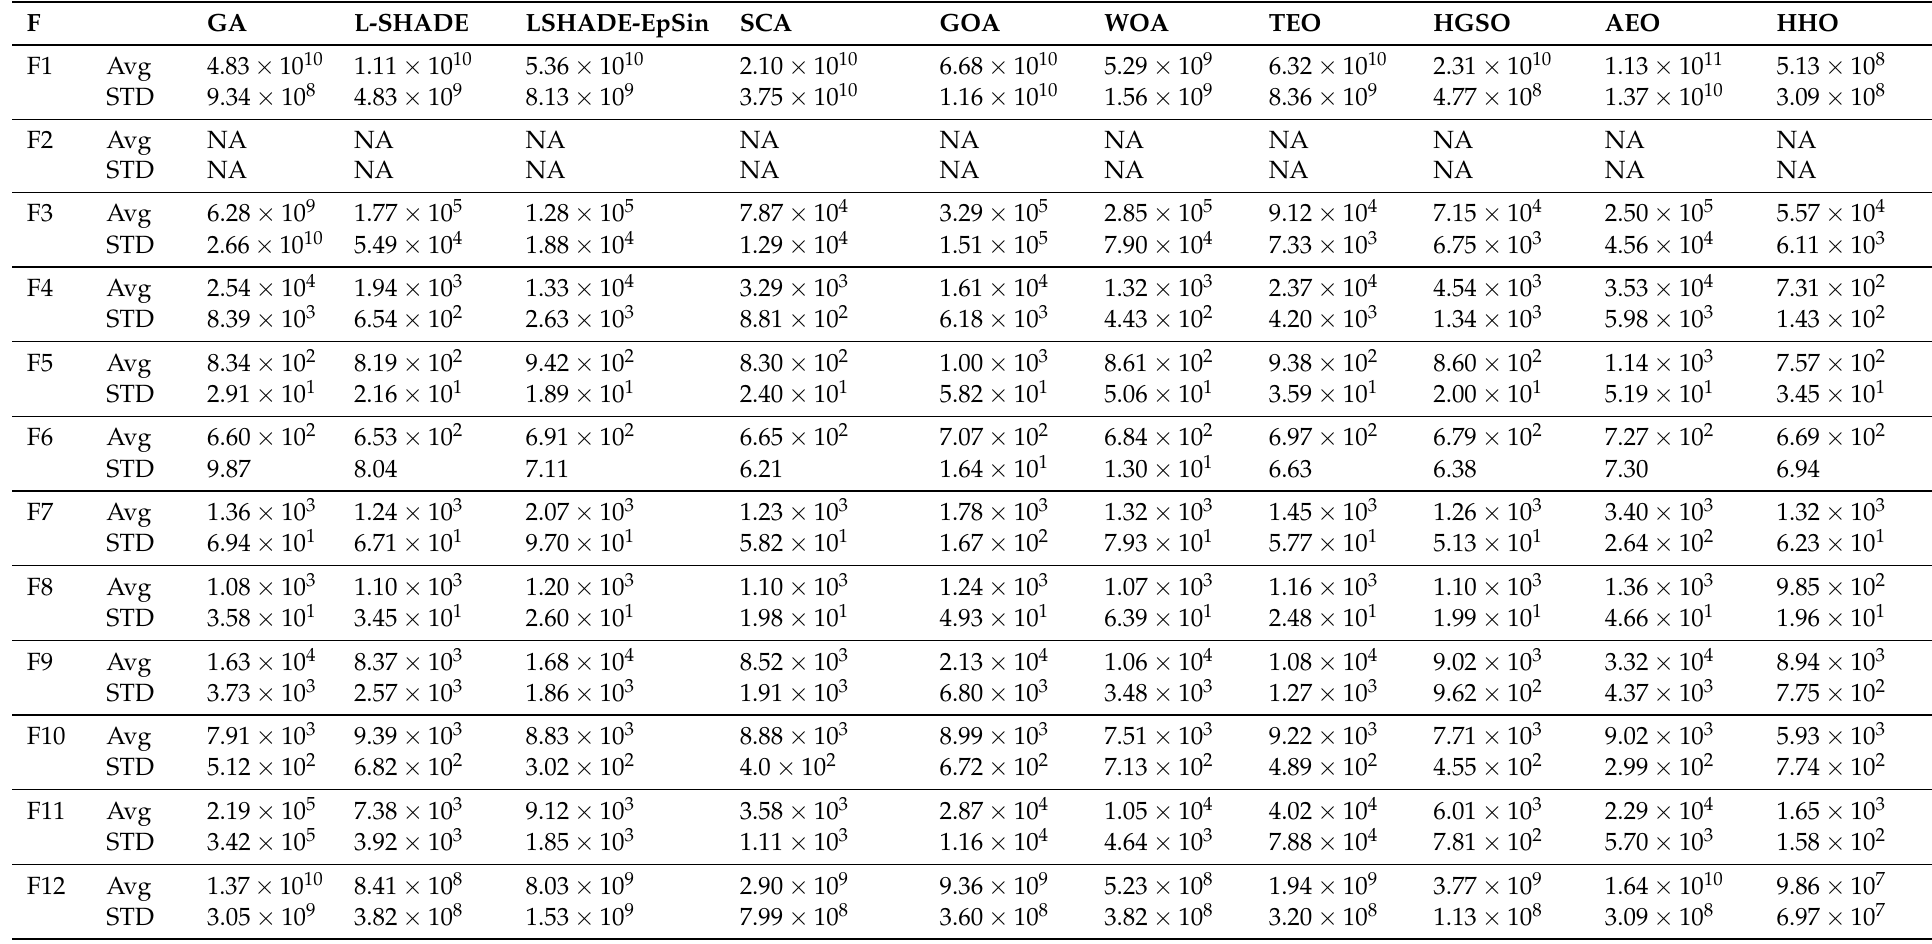
Table 6. The comparison results of all algorithms over 30